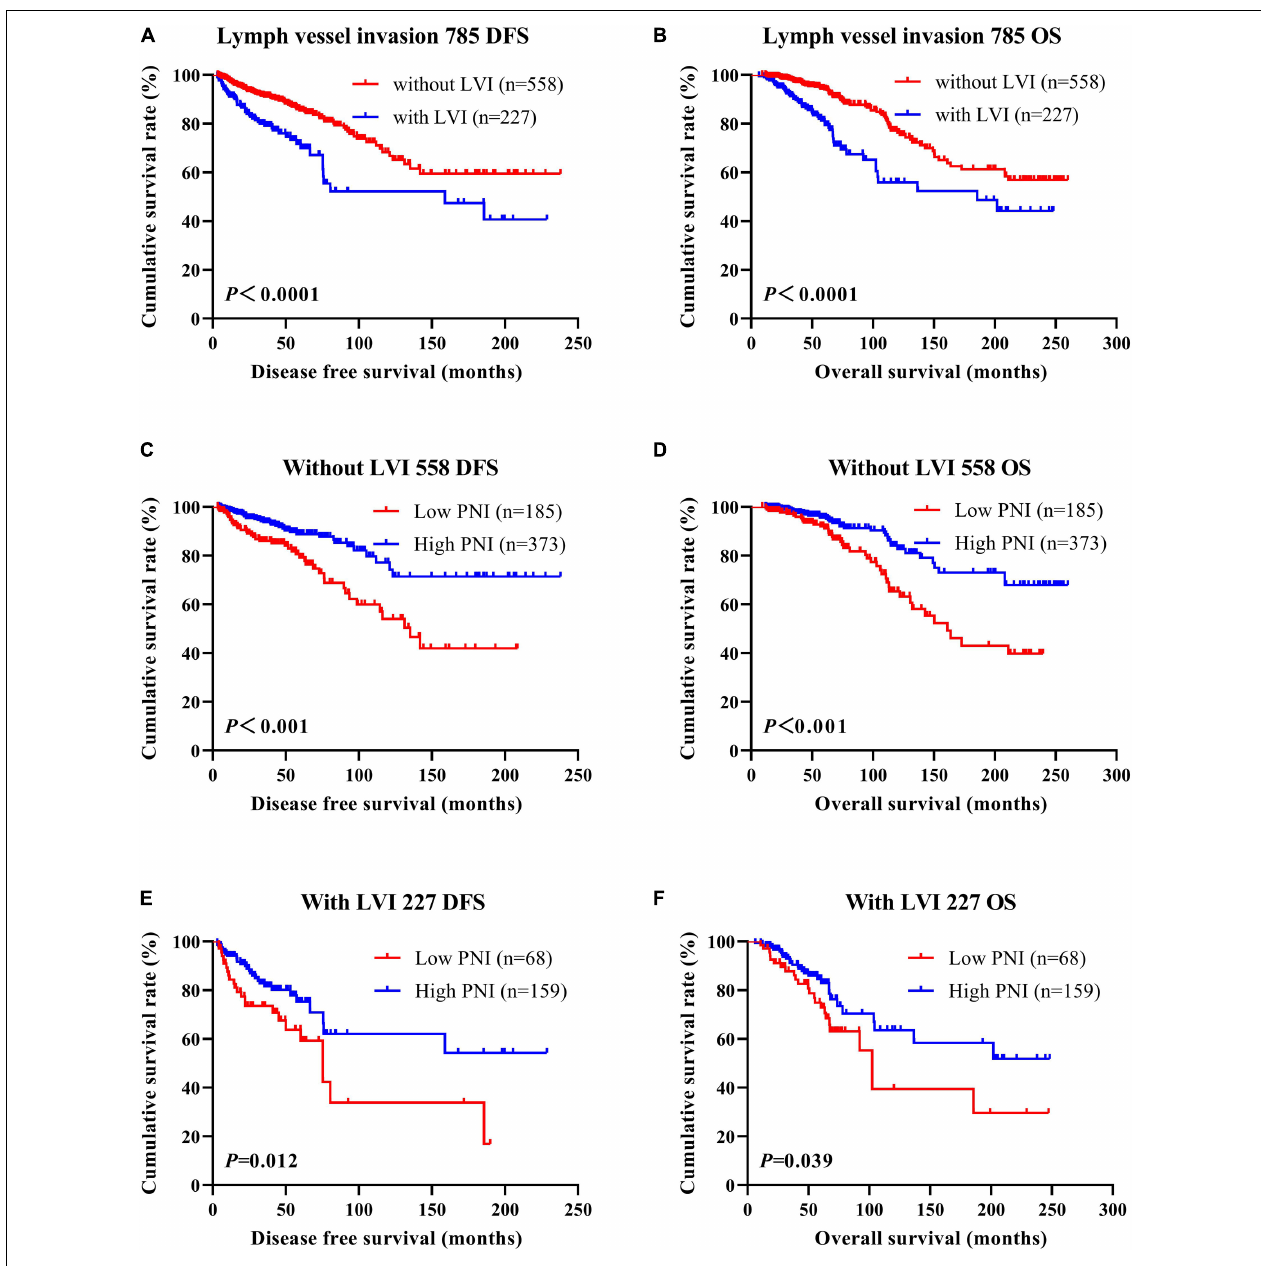
FIGURE 6 | Disease-free survival (DFS) and overall survival (OS) of patients with breast cancer by lymph vessel invasion status. (A,B) Kaplan–Meier analysis of the DFS (A) and OS (B) of breast cancer patients by lymph vessel invasion status. (C,D) Kaplan–Meier analysis of the DFS (C) and OS (D) of patients without lymph vessel invasion by prognostic nutritional index (PNI). (E,F) Kaplan–Meier analysis of the DFS (E) and OS (F) of patients with lymph vessel invasion by